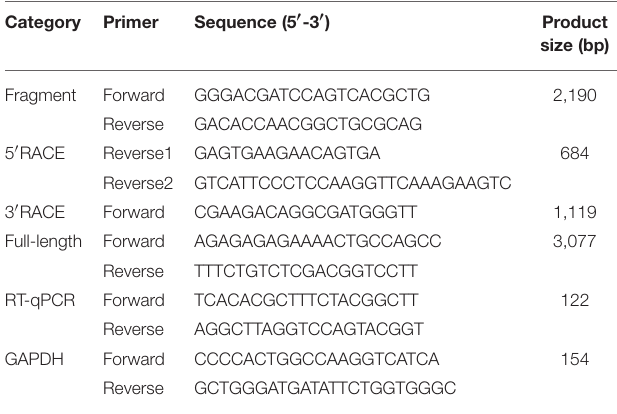
TABLE 1 | Primers used for cloning and